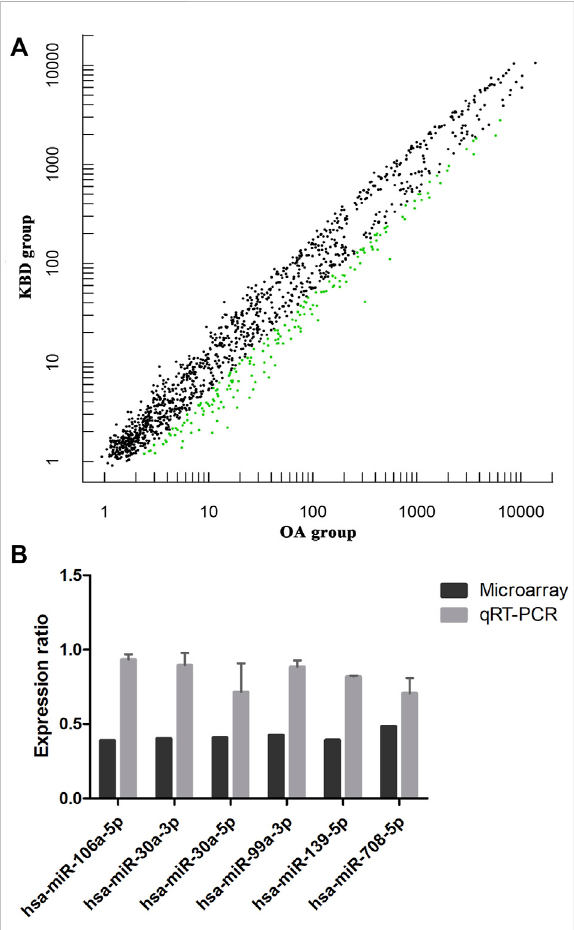
FIGURE 5 Microarray pro fi ling analysis of differentially expressed miRNAs in subchondral bone between patients with KBD and OA. (A) ,Scatterplot fi lteringofthedifferentiallyexpressedmiRNAs.The green points represent signi fi cantly downregulated miRNAs intheKBDversusOAgroup,andtheblackpointsaregeneswithno signi fi cant differences. (B) , Validation of six differentially expressed miRNAs by